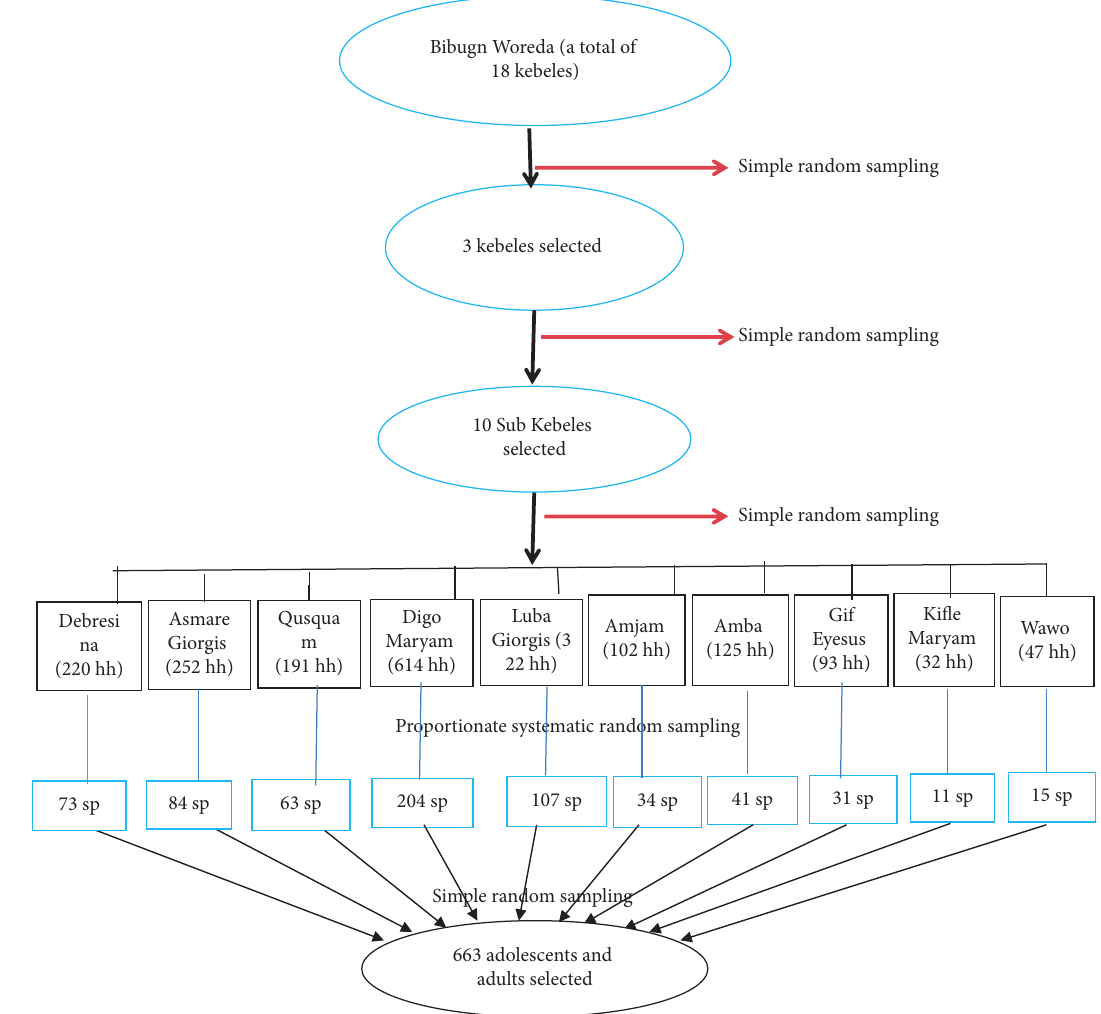
Figure 1: The flow of study participants’